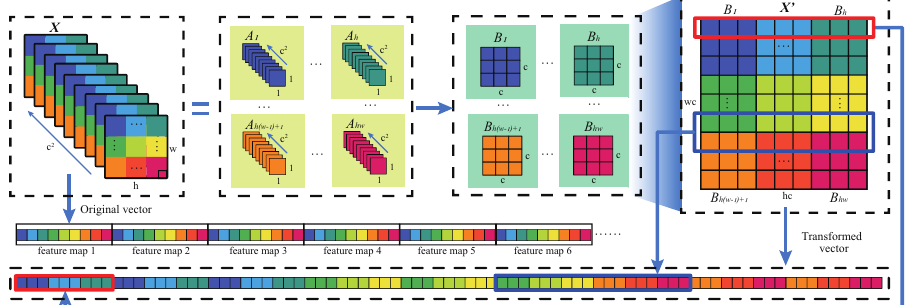
Figure 2. Schematic diagram of the process of homology shifting